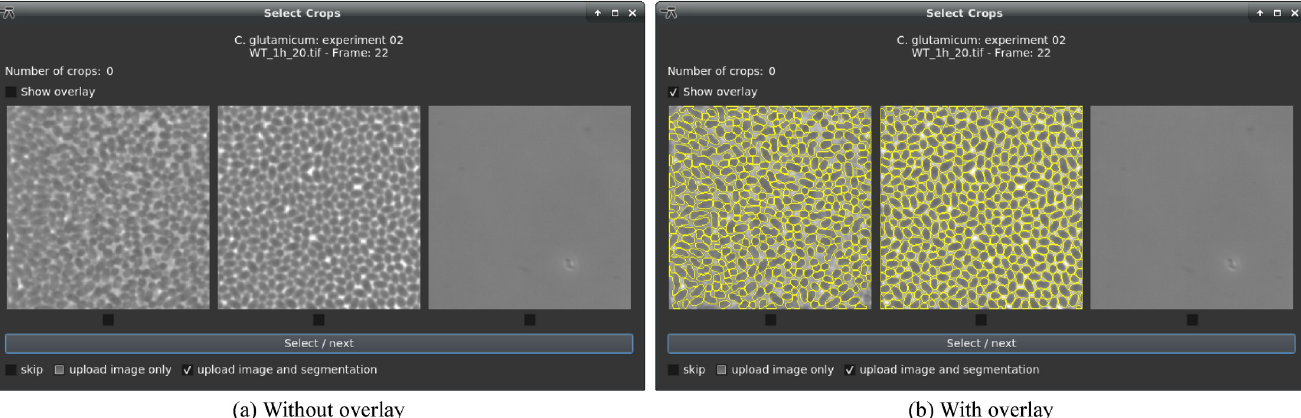
PLOS ONE | https://doi.org/10.1371/journal.pone.0277601 November29,